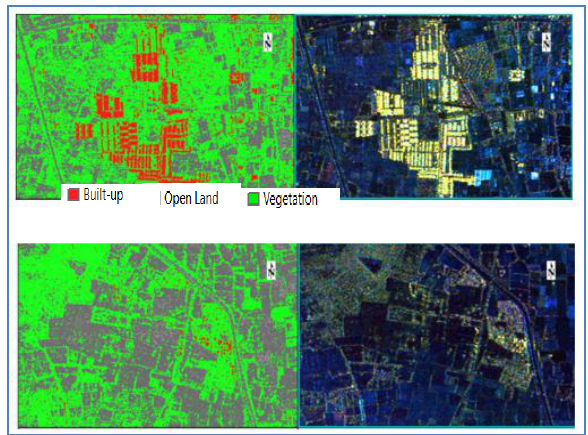
Figure 9: Patches of built-up area in classified image compared with m-delta decomposition